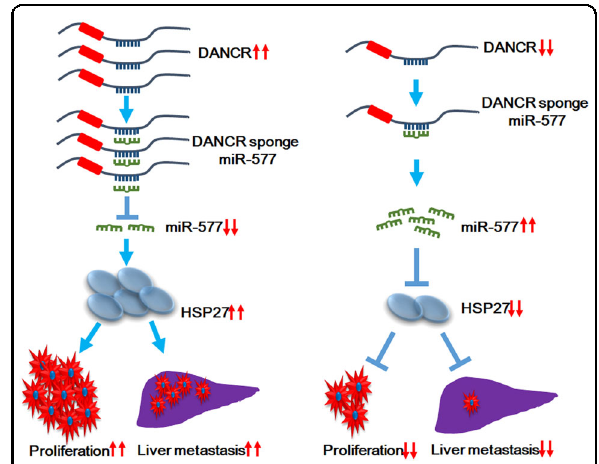
Fig. 9 Schematic diagram of the mechanism underlying this study. DANCR promotes colorectal cancer proliferation and metastasis by promoting HSP27 expression via the sponging of